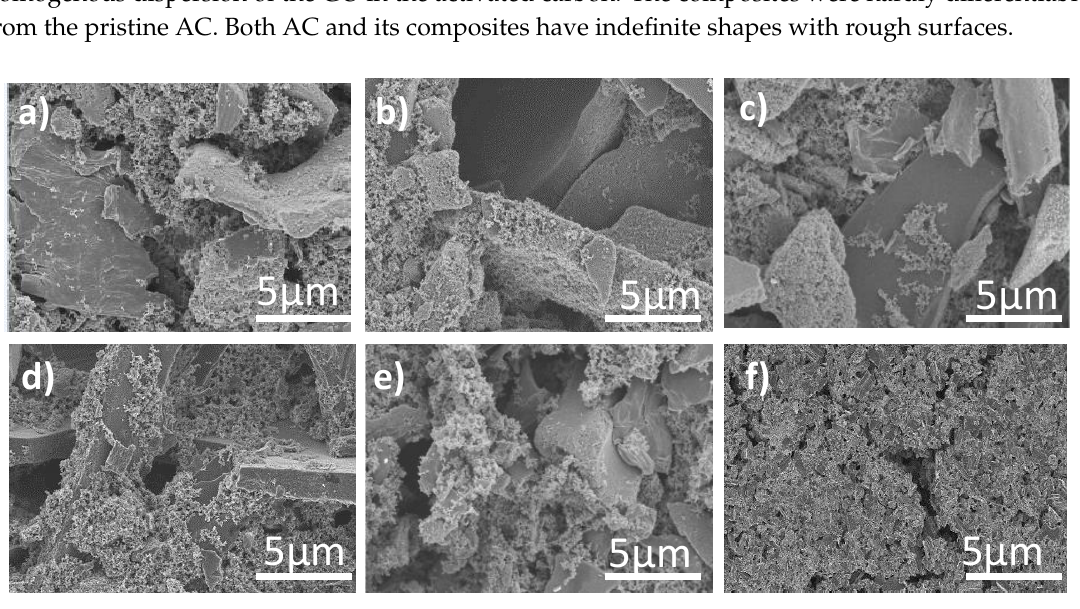
Figure 3. Field emission scanning electron microscope (FESEM) top view of: ( a ) AC ( b ) AC / GO-5 ( c ) AC / GO-10 ( d ) AC / GO-15 ( e ) AC / GO-20 and ( f ) GO-electrode.